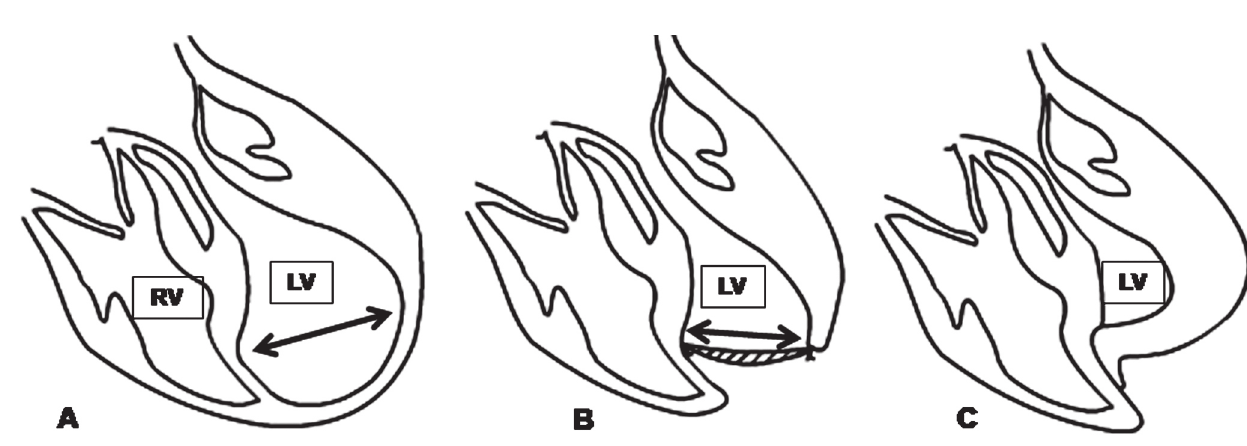
Fig. 4 - Schematic drawing of the concept of the procedure. A. The enlarged LV with the aneurysmal area. B. Dor procedure with the intraventricular patch (arrow). C. The remnant LV after the patchless technique. RV-right ventricle. LV-left